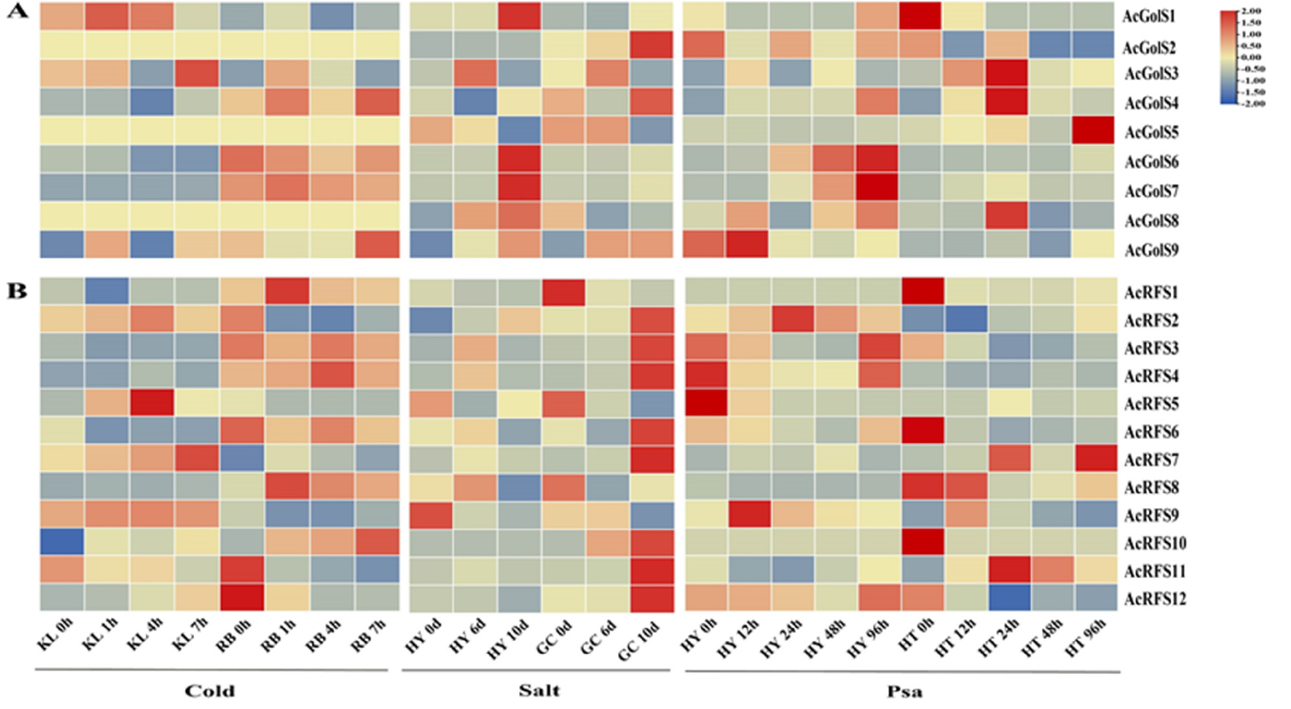
Figure 5. Expression analysis of AcGolS and AcRFS genes under cold, salt, and Psa. ( A ) Expression profiles of AcGolS genes; ( B ) Expression profiles of AcRFS genes. To the figures’ right, the color bar represents the log2 FPKM (fragments per kilobase of exon per million reads mapped) value.